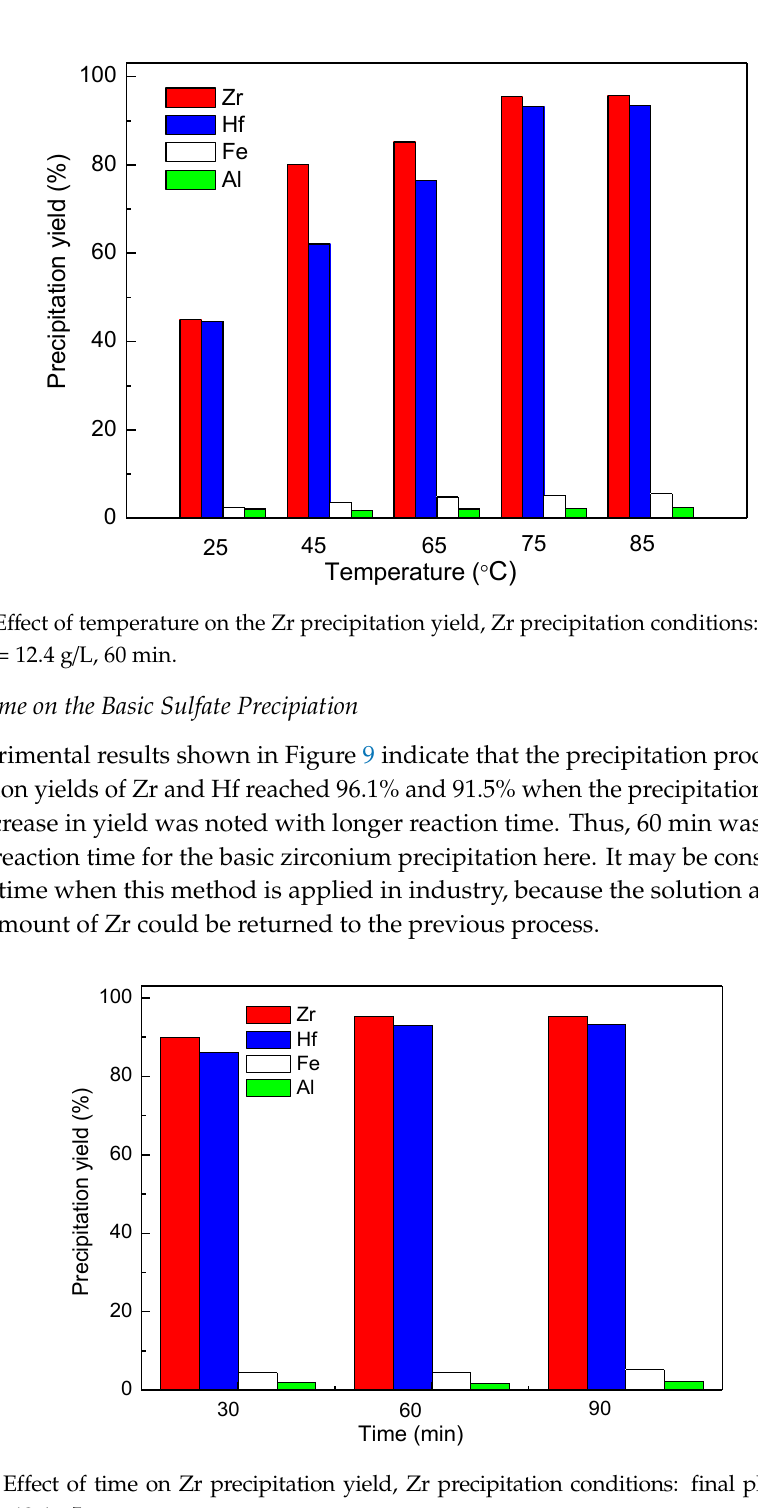
2.0 Figure 7. Effect of pH on the Zr precipitation yield, Zr precipitation conditions: 75 °C, C(SO 42‒ ) = 12.4 g/L, 60 min. 3.4 Effect of Temperature on the Basic Sulfate Precipiation